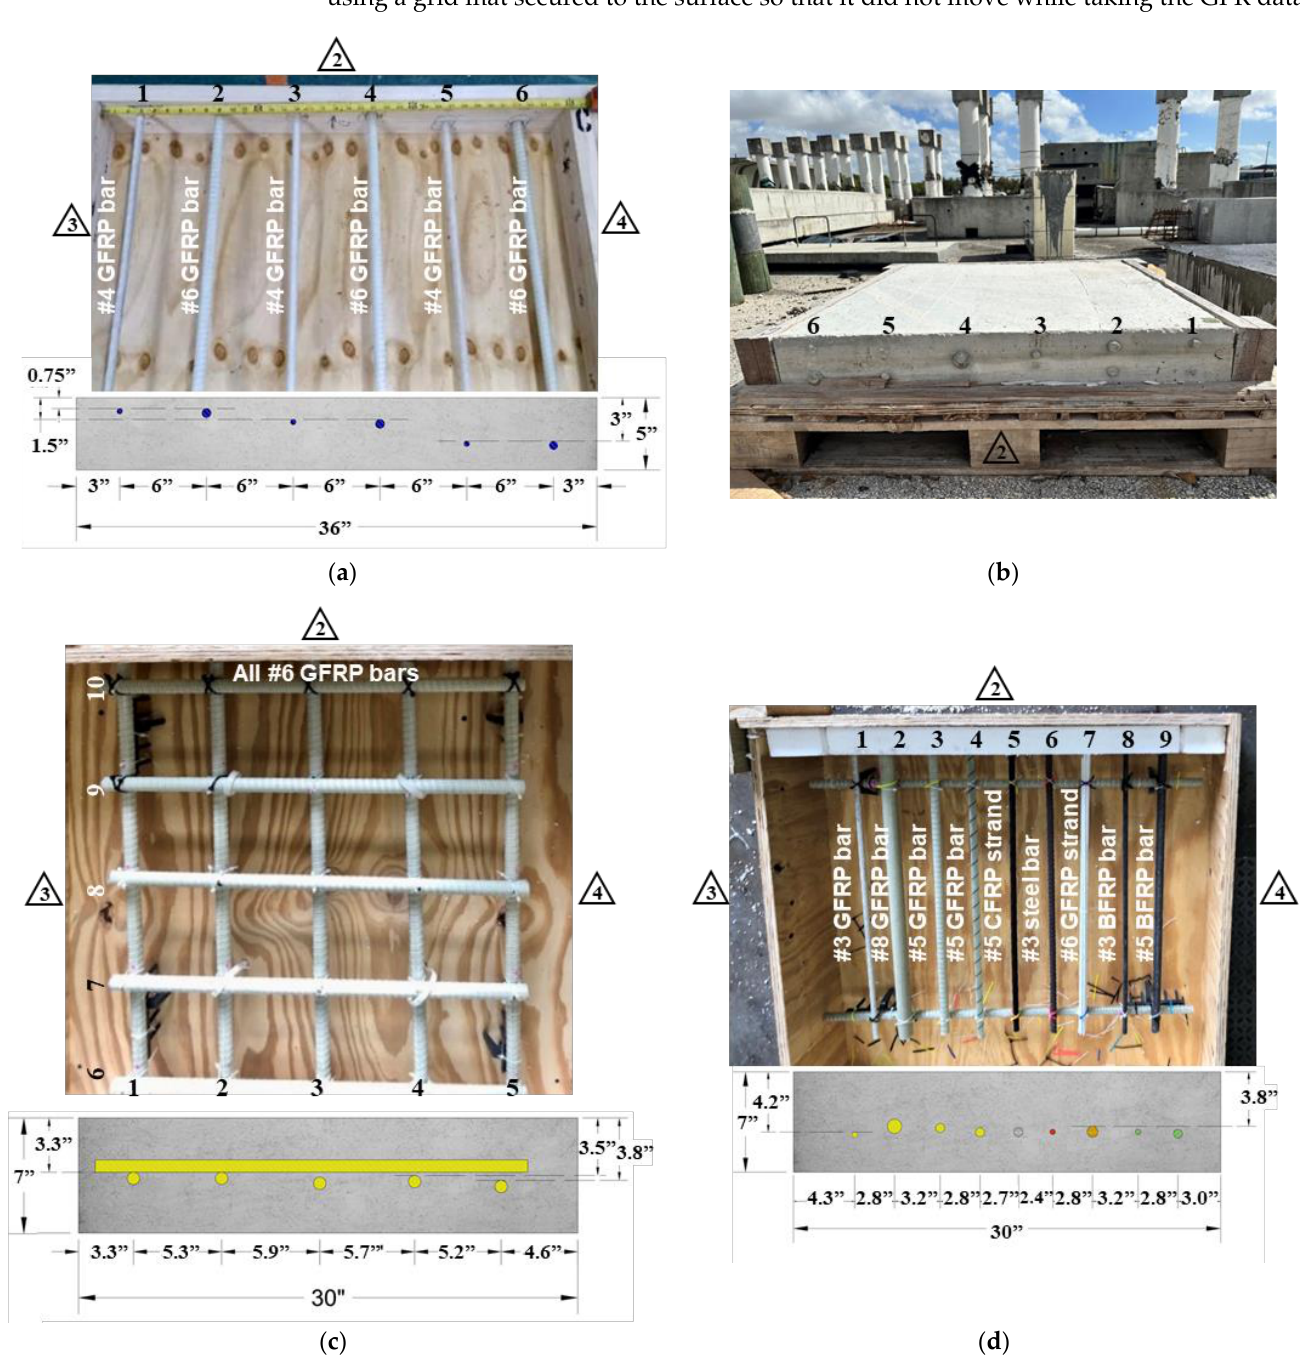
Figure 2. FRP bars in different slabs: ( a , b ) Slab C, ( c ) Slab J, ( d ) Slab L.